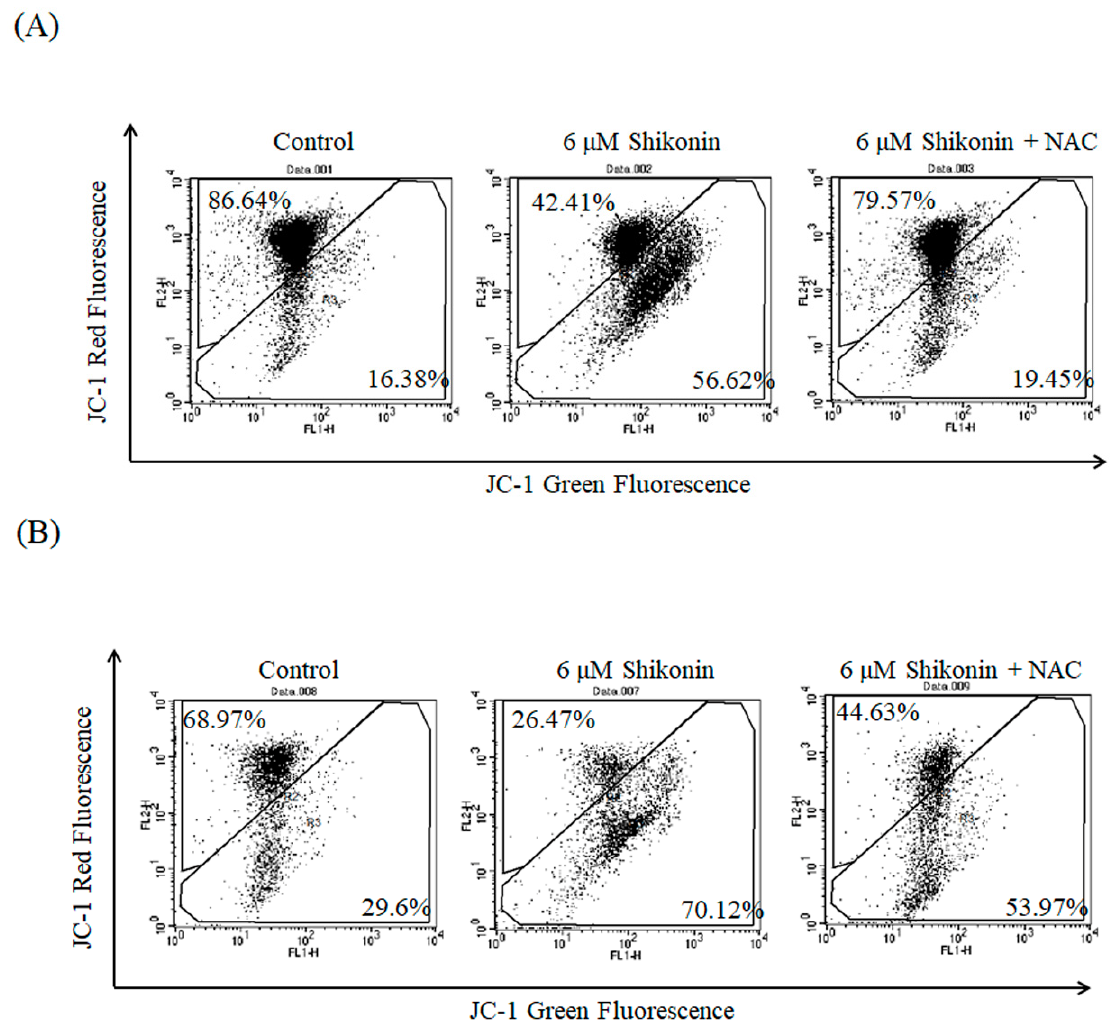
Figure 5. Shikonin disrupted mitochondrial membrane potential in RCC cells. ACHN ( A ) and Caki-1 ( B ) cells were treated with shikonin for 24 h with or without pretreatment with NAC and then stained with JC-1. Data represent the flow cytometry analysis of JC-1 staining.